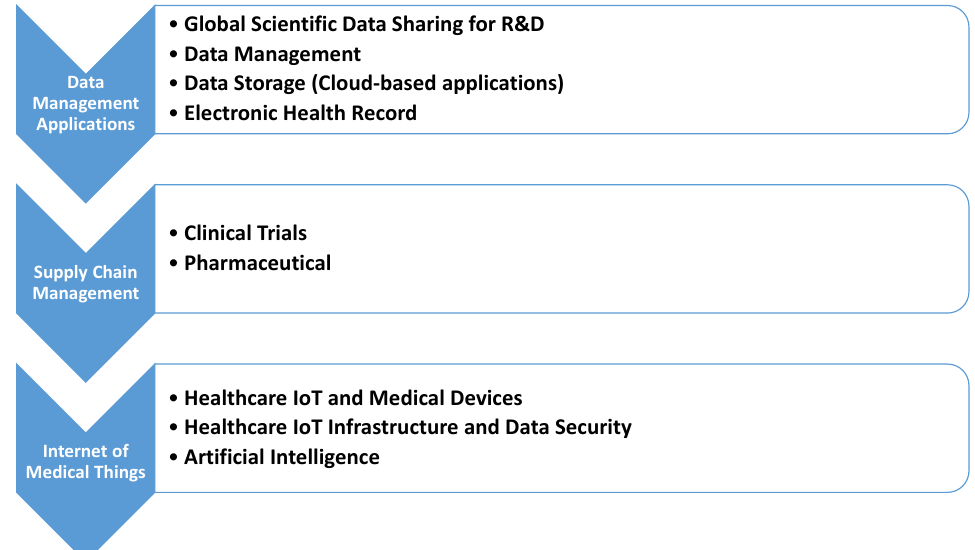
Figure 2. Blockchain-based healthcare applications.